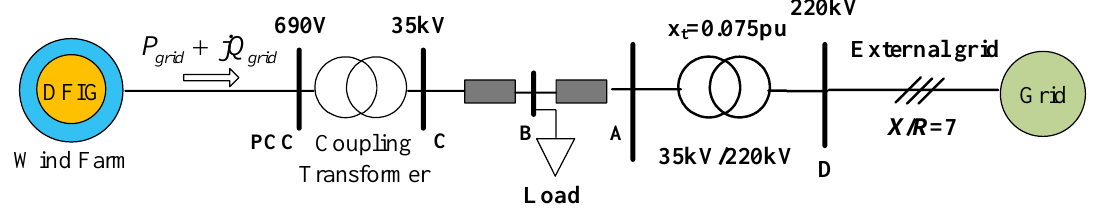
Figure 11. Schematic diagram of the test